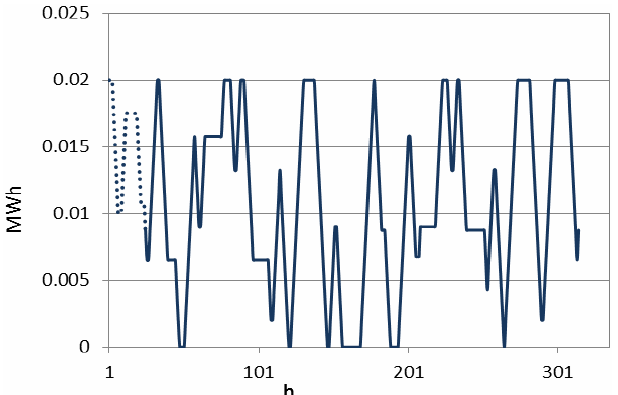
Figure 16. ESS SOC course along 14 days obtained—unstable scenario.